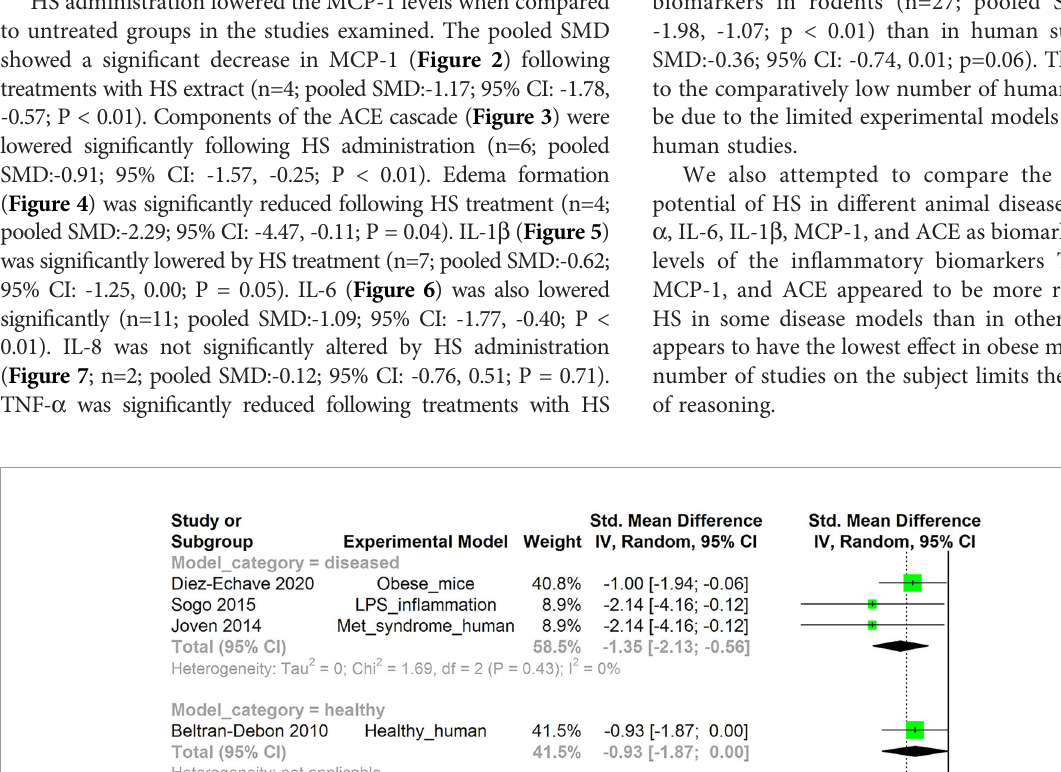
( Figure 8 : n=10; pooled SMD:-1.55; 95% CI: -2.43, -0.67; P < 0.01). The levels of CRP ( Figure 9 : n=4; pooled SMD: 0.05; 95% CI: -0.26, 0.36; P = 0.75), IL-10 ( Figure 10 : n=4; pooled SMD:-0.38; 95% CI: -1.67, 0.91; P = 0.56), and iNOS ( Figure 11 : n=2; pooled SMD:-0.69; 95% CI: -1.60, 0.23 P = 0.14) were not signi fi cantly affected by HS